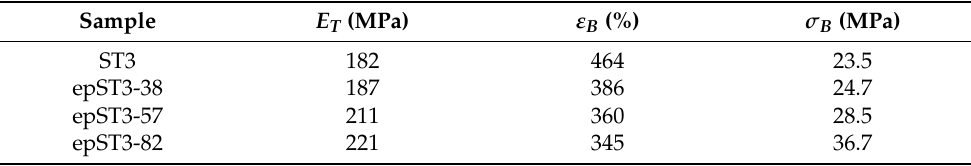
Table 3. Some of the tensile mechanical characteristics of ST and epST-x. Sample E T (MPa) ST3